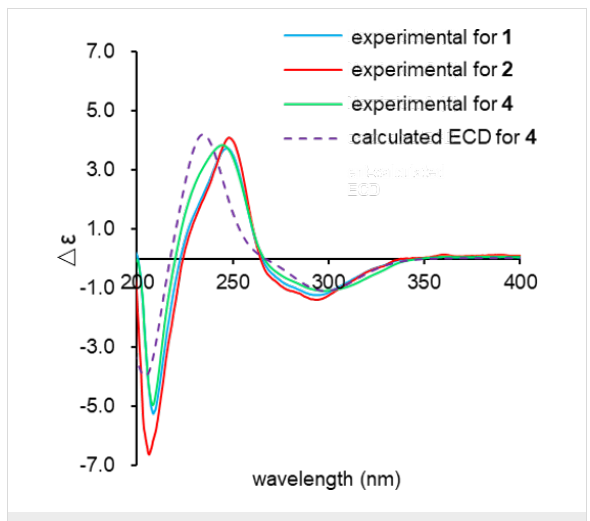
Figure 4: Experimental ECD spectra of 1 , 2 , and 4 and calculated ECD spectrum of 4